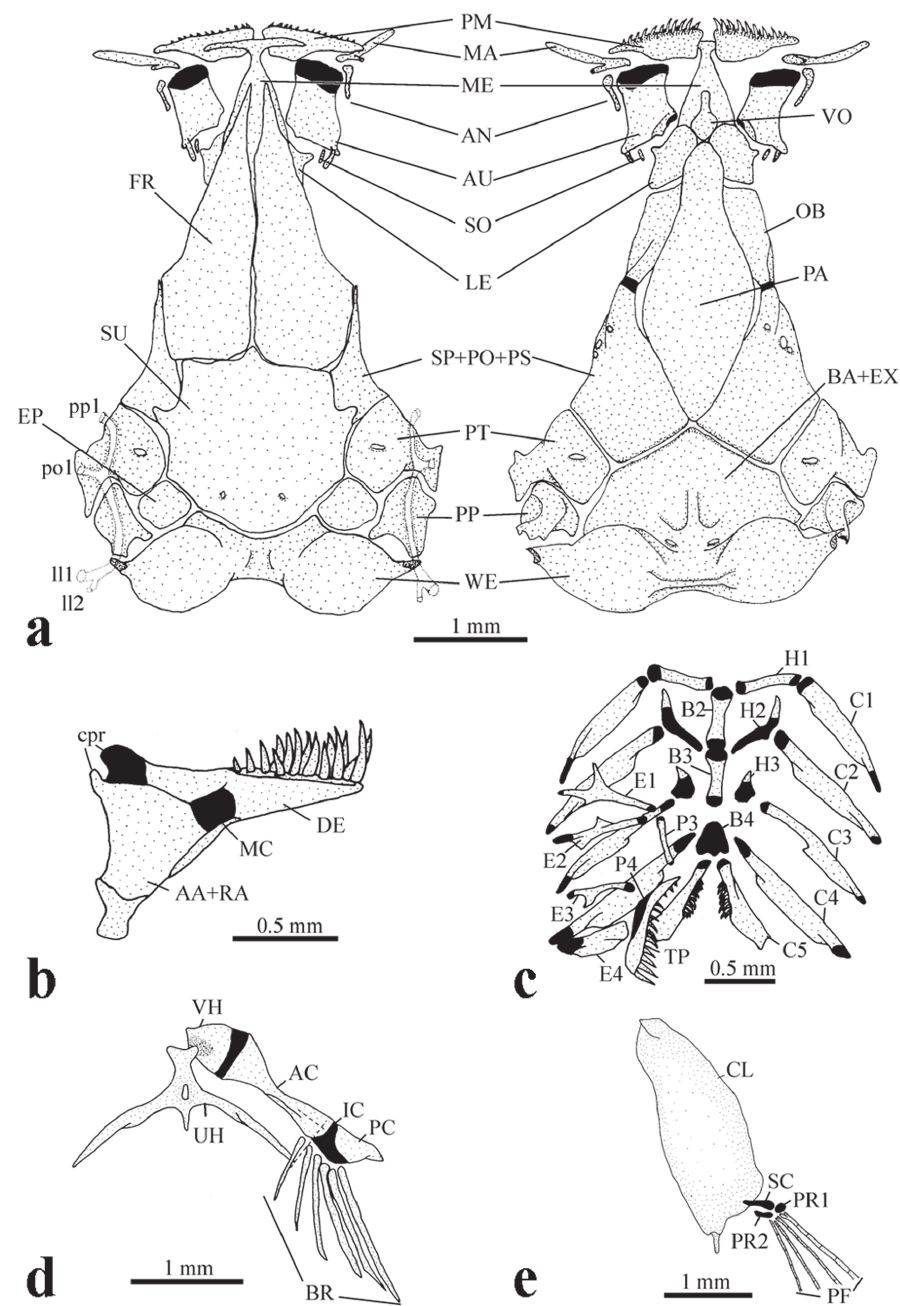
Fig. 5. Skeleton of Listrura camposi , MNRJ 37023, 35.7 mm SL. ( a ) Skull and Weberian capsule in dorsal (left) and ventral (right) views. ( b ) Lower jaw, left side; internal view. ( c ) Gill arches, dorsal view. Right dorsal elements not drawn. ( d ) Hyoid arch, left side: ventral view. Dashed lines indicate the tip of the lateral process of parurohyal in relation to ceratohyals. ( e ) Pectoral girdle, left side: ventral view. Legends: AA+RA - angulo-articular and retro-articular co-ossified, AC - anterior ceratohyal, AN - antorbital, AU - autopalatine, B2-4 - basibranchials 2 to 4, BA+EX - fused basioccipital-exoccipitals, BR - branchiostegal rays, C1-5 - ceratobranchials 1 to 5, CL - cleithrum, cpr - coronoid process, DE - dentary, E1-4 - epibranchials 1 to 4, EP - epioccipital, FR - frontal, H1-4 - hypobranchials 1 to 4, IC - interceratohyal cartilage, LE - lateral ethmoid, ll1-2 - pores 1 and 2 of main lateral line, MA - maxilla, MC - Meckel cartilage, ME - mesethmoid, OB - orbitosphenoid, P3-4 - pharyngobranchials 3 and 4, PA - parasphenoid, PC - posterior ceratohyal, PF - pectoral-fin rays, PM - premaxilla, PP - “posttemporosupracleithrum”, pp1 - pore 1 of preopercular canal, po1 - pore 1 of postotic canal, PT - pterotic, PR1-2 - proximal radials 1 and 2, RA - retro-articular, SC - scapulocoracoid, SO - sesamoid supraorbital, SP+PO+PS - fused sphenotic-prootic-pterosphenoid, SU - parieto-supraoccipital, TP - tooth plate, UH - parurohyal, VH - ventral hypohyal, VO - vomer, WE - Weberian